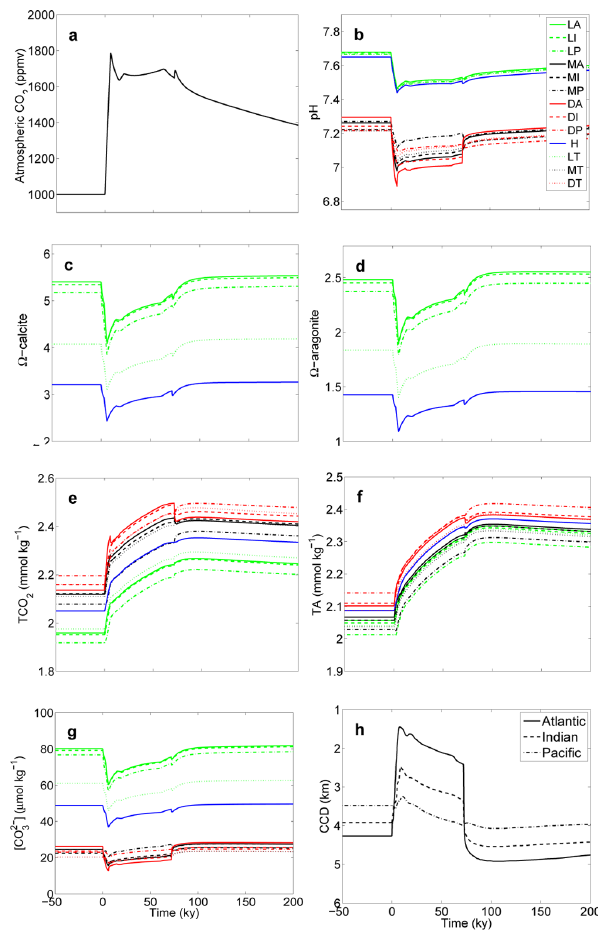
Fig. 7. Example of a PETM carbon release scenario simulated in LOSCAR: initial release of 3000PgC over a few thousand years (see Zeebe et al., 2009). L = Low-latitude, M = interMediate, D = Deep, H = High-latitude. A = Atlantic, I = Indian, P = Pacific, T = Tethys. See text for